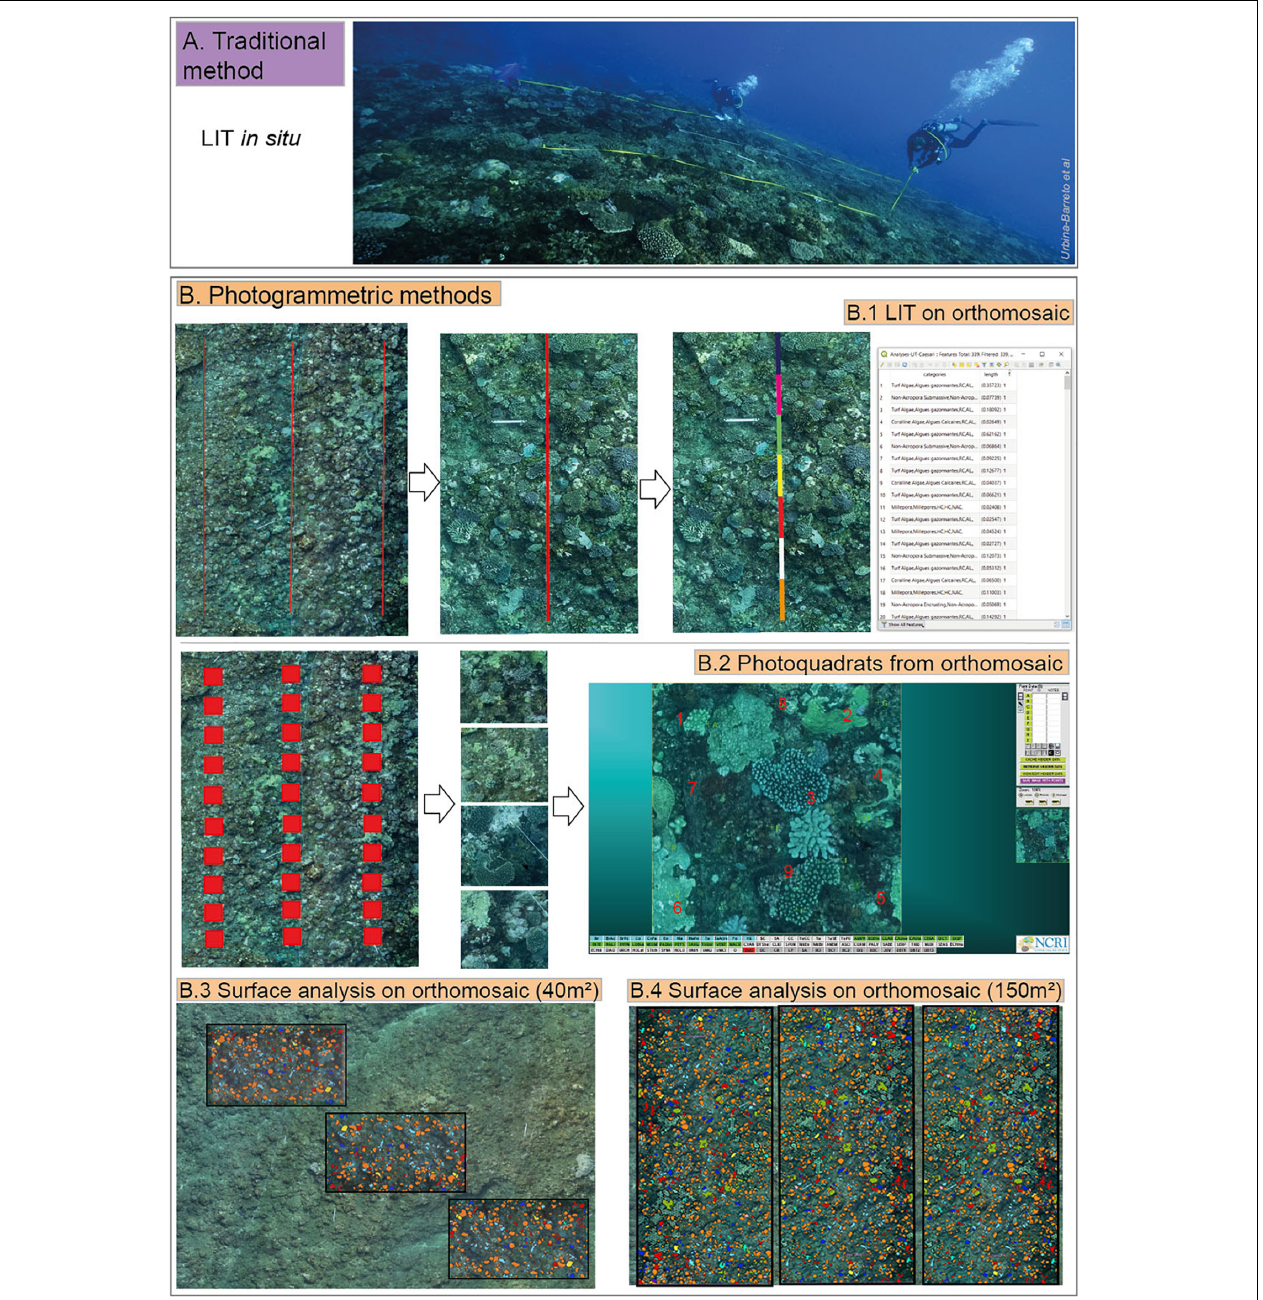
FIGURE 2 | Illustration of the traditional method: LIT in situ , sampling distance 20 m × 3 (A) and the photogrammetric methods (B) : LIT on orthomosaic, sampling distance 20 m × 3 (B.1) ; photoquadrats from orthomosaic, sampling area 1 m 2 × 10 × 3 (B.2) ; and surface analyses on orthomosaic: sampling area of 40 m 2 × 3 (B.3) and sampling area of 150 m 2 × 3 (B.4) colors show different benthic